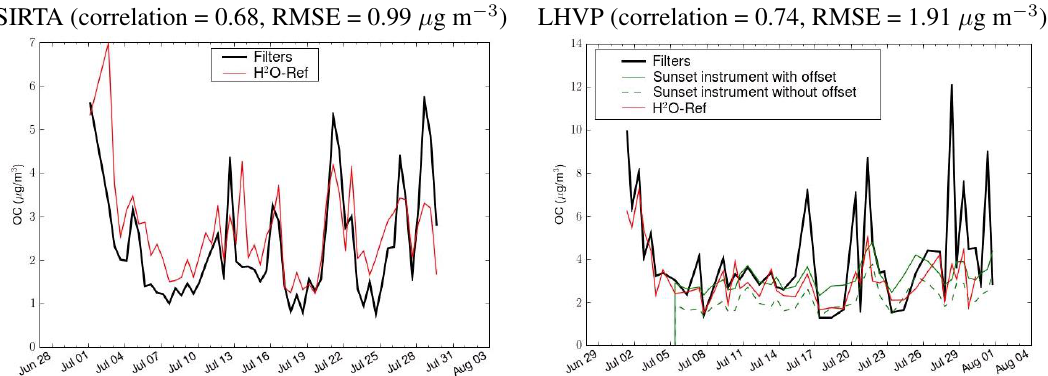
Fig. 5. 12 h averaged concentrations of OC modeled with “H 2 O-Ref” and measured with filters at the SIRTA (left) and with both filters and Sunset field instrument at the LHVP (right) site (correlations and RMSE are between the model and the filter measurements).